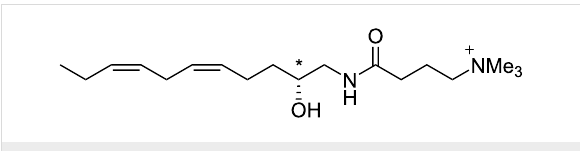
Figure 1: Structure of ( R )-(−)-complanine.